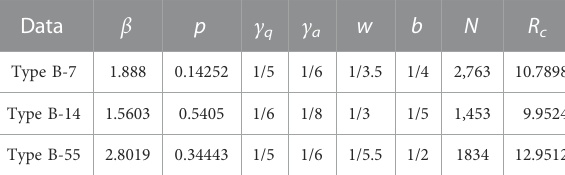
TABLE 3 Values of model parameters and control reproduction number in three types of